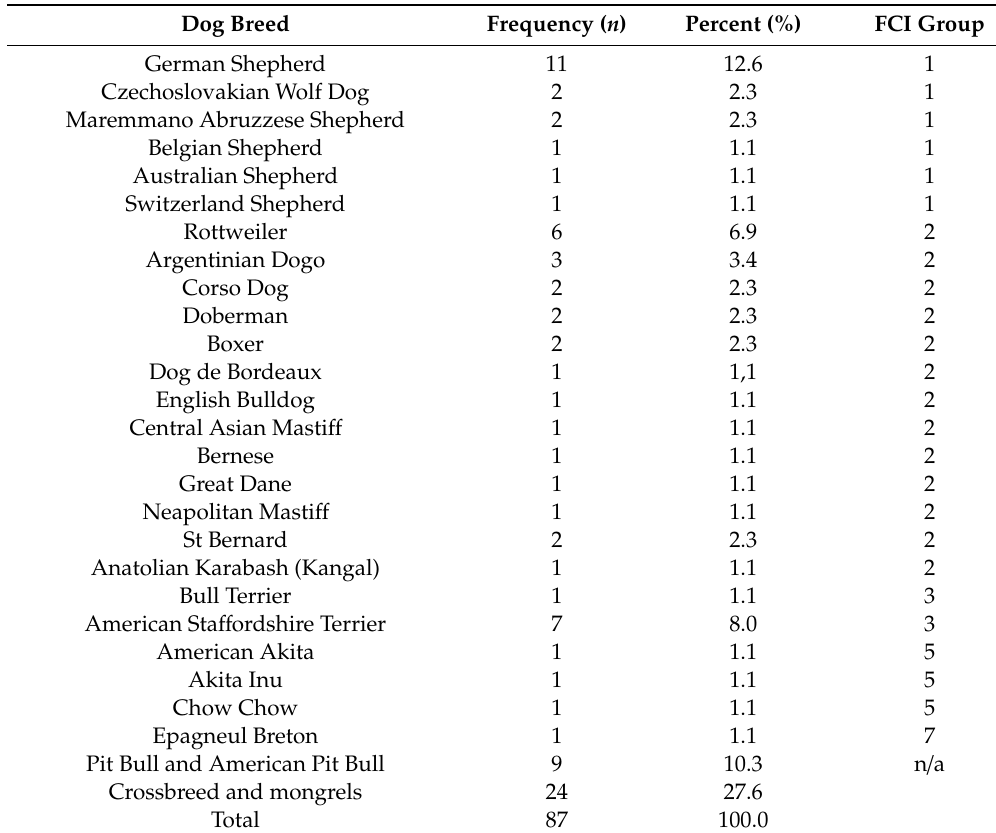
Table 8. Breed and FCI group of dogs aggressive towards human